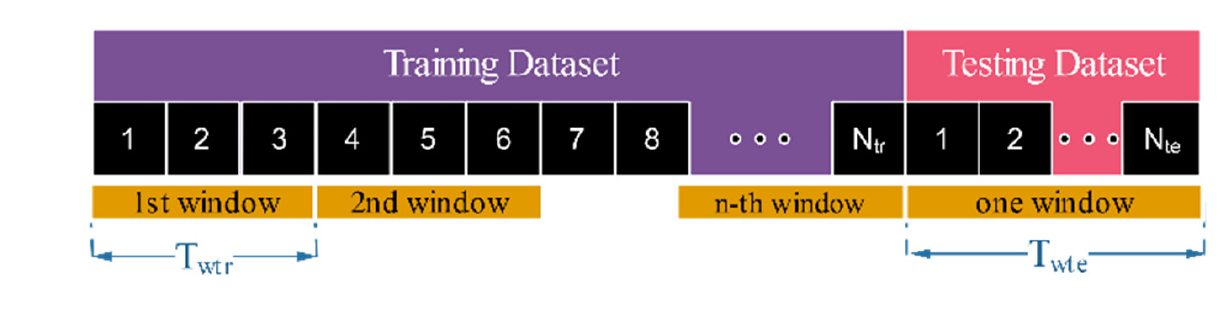
Figure 3. Resampling only (RO).